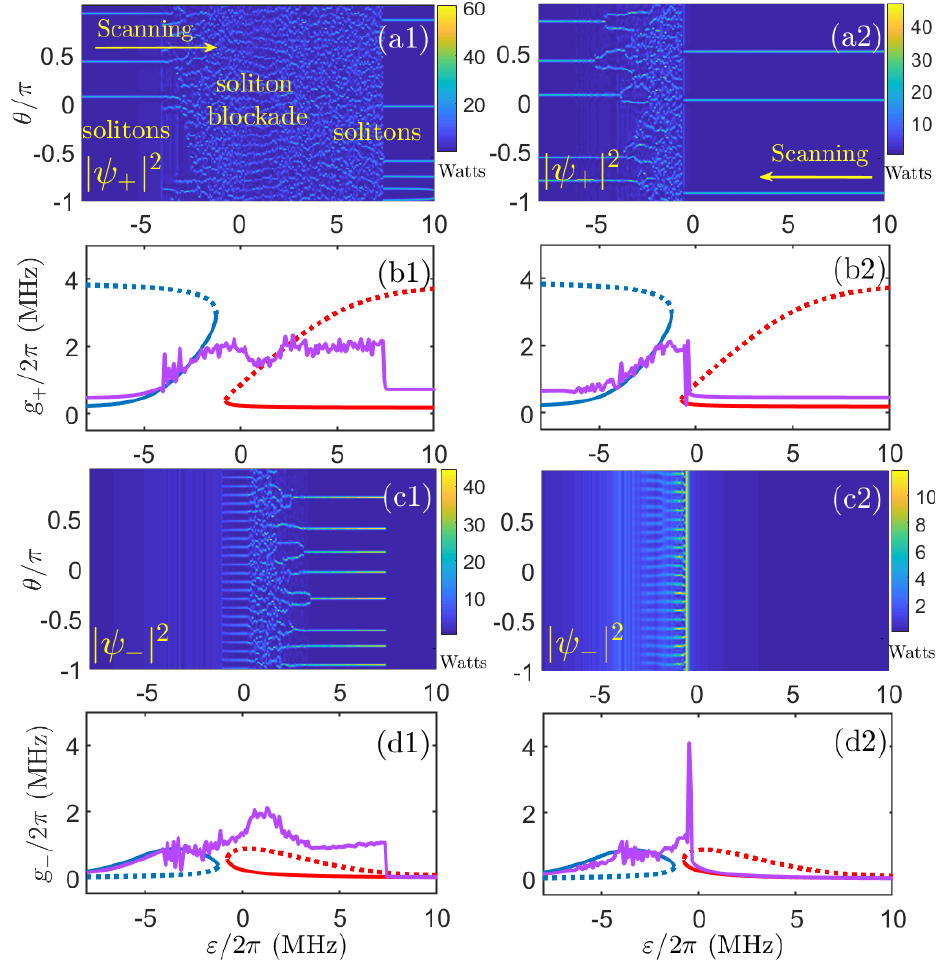
Figure 6. The soliton blockade in the plus field as is realized using the forward ( a1 ) and reverse ( a2 ) adiabatic scans of ε , i.e., by tuning ω − ; δ 0 /2 π = 4.5 MHz, H + = H − = 4W 1/2 . ( b1 , b2 ) The magenta line shows g + vs. time. The blue and red lines are g + for the cw-cw solution. ( c1 , c2 ) The same as ( a1 , a2 ) but for the minus field. ( d1 , d2 ) The same as ( b1 , b2 ) but for g −